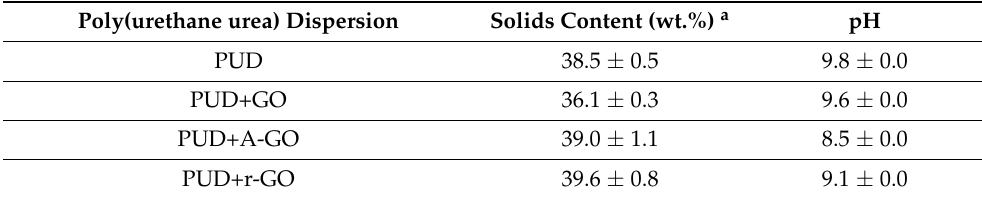
Table 4. Solids content and pH values of the PUDs.